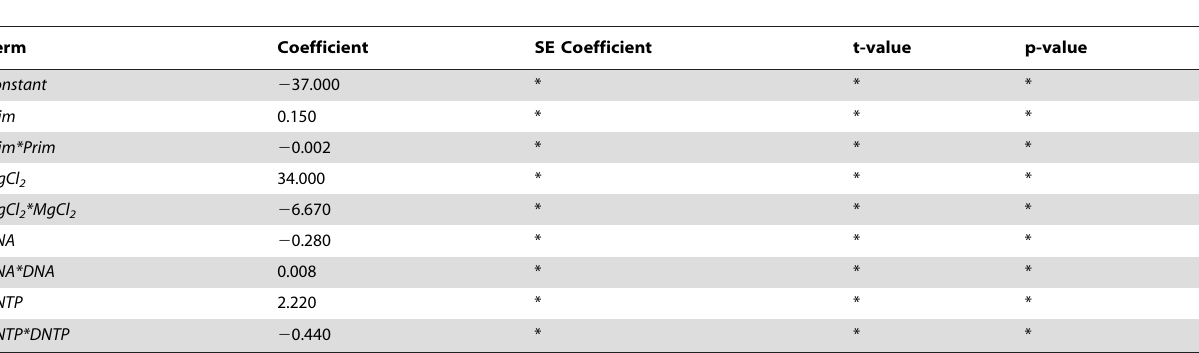
Table 5. General Linear Model results for the PCR data of epidemiological typing of Pseudomonas aeruginosa above (MINITAB